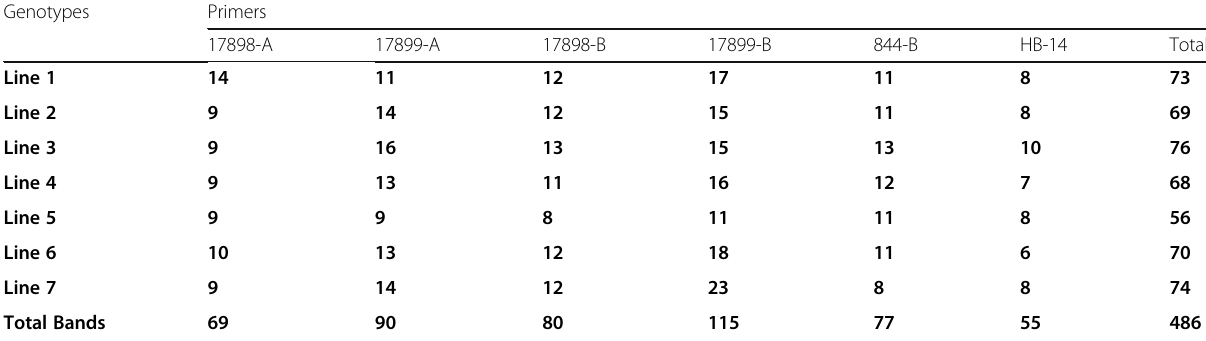
Table 7 Total bands produced from each primer for 7 wheat lines and all amplified fragments in each genotype